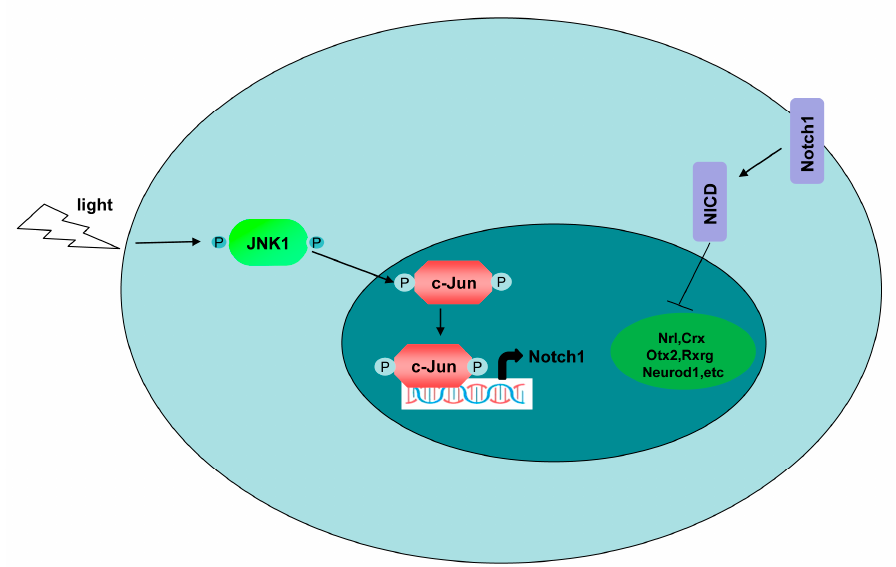
Figure 8. Schematic diagram of the JNK1–c-Jun–Notch1 axis. Upon Light stimulation, JNK1 was activated and translocated from the cytoplasm to phosphorylate c-Jun in the nucleus. Phosphorylated c-Jun was activated and promoted Notch1 transcription by binding to the transcriptional regulatory region of Notch1. Notch1 is a well-known negative regulator of photoreceptor genesis through inhibiting photoreceptor-related transcription factors (Nrl, Crx, Otx2, Rxrg, Neurod1, etc). Taken together, JNK1 regulated photoreceptor genesis through Notch1 via c-Jun.